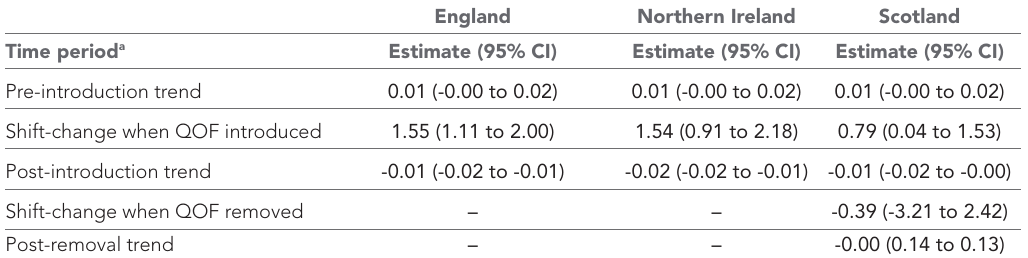
Table 2 Interrupted time- series model results comparing monthly resolved atrial fibrillation